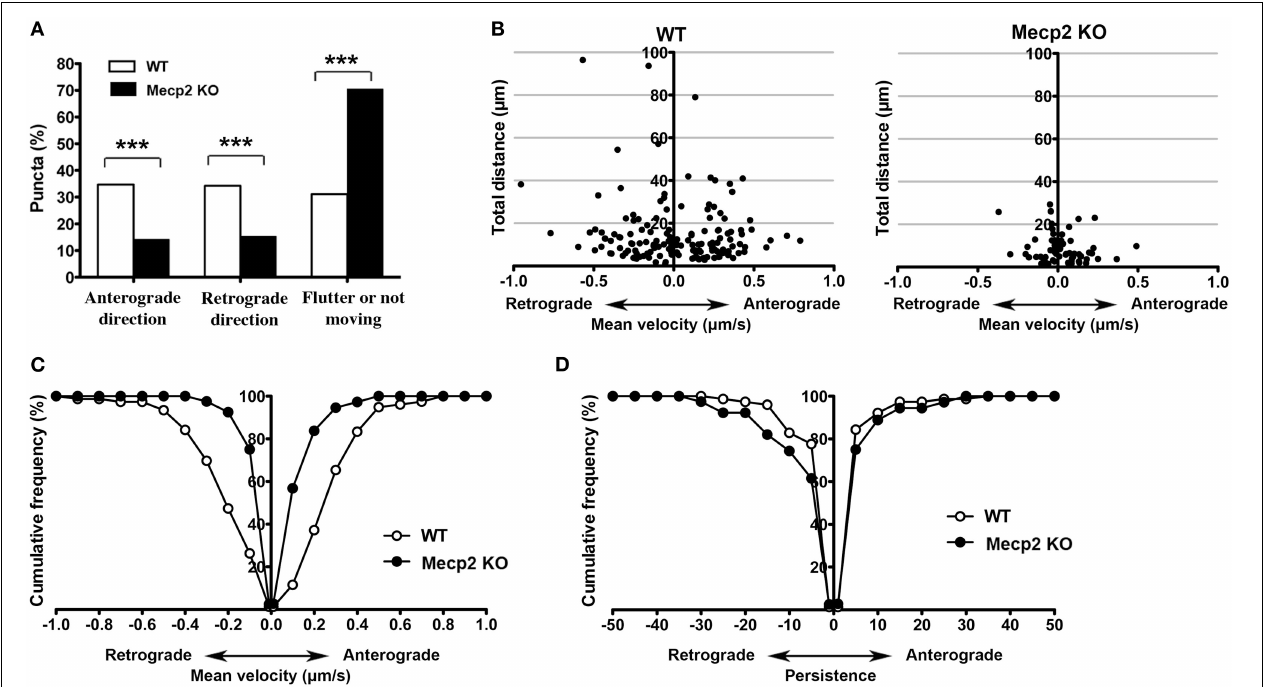
FIGURE 2 | Bi-directional BDNF-YFP trafficking is impaired in Mecp2 knockout neurons. (A) Proportion of BDNF-YFP puncta that moves in the anterograde or retrograde directions, flutter within a small distance (10 μ m) or not moving at all in wildtype and Mecp2 knockout neurons. (B) Scatter plots showing analyses of movement of BDNF-YFP puncta in